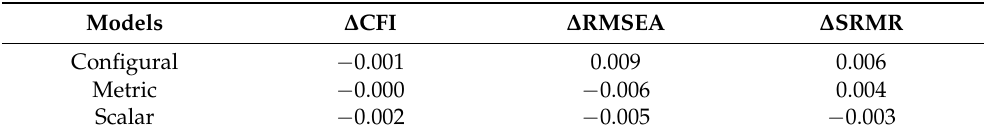
Table 2. Results of Measurement Invariance analyses across gender (males, females). ∆ CFI, ∆ RMSEA and ∆ SRMR = differences in Comparative Fit Index (CFI), Root-Mean-Square Error of Approximation (RMSEA), and Standardized Root Mean Residual